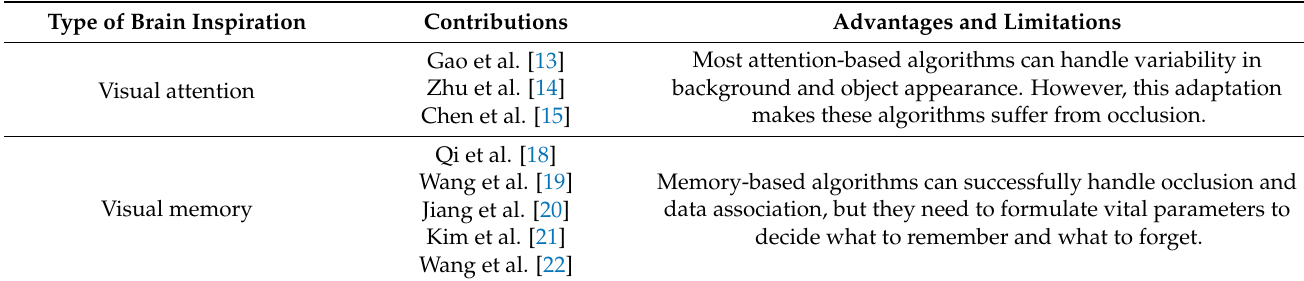
Table 1. Human brain-inspired